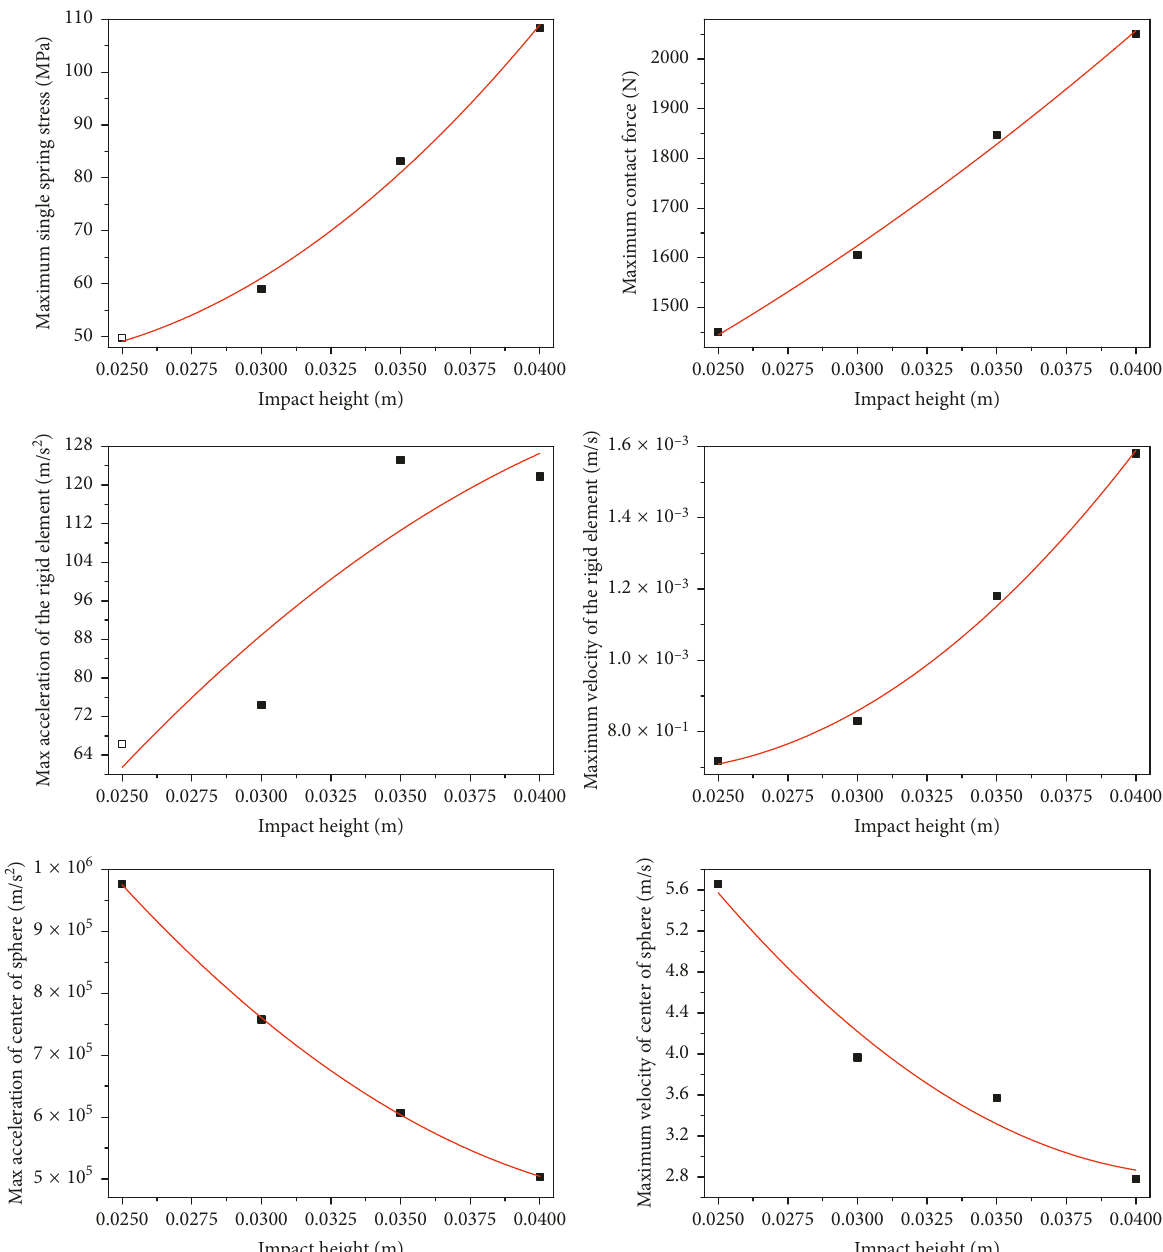
Figure 36: Maximum contact